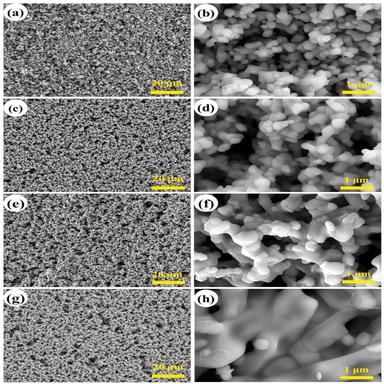
Surface morphology of the TiO2 coating sintered at different temperature for 1 h, (a, b) 800 ◦C, (c, d) 900 ◦C, (e, f) 1000 ◦C, and (g, h) 1100 ◦C.